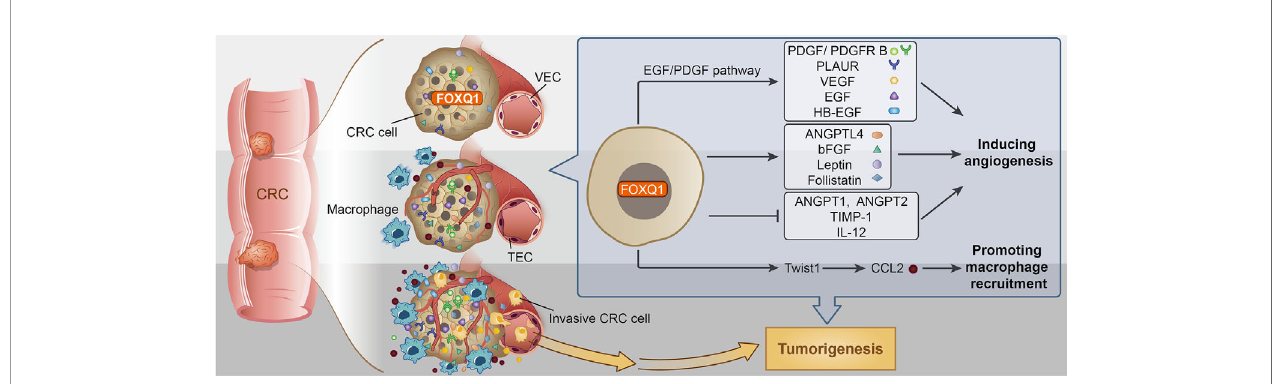
FIGURE 8 | Potential mechanism for Forkhead box Q1 (FOXQ1) induced angiogenesis and macrophage in fi ltration in colorectal cancer (CRC) tumorigenesis. We speculate that FOXQ1 can promote the migration of endothelial cell in tumor microenvironment (TME), improve microvessel morphogenesis, as well as strengthen intercellular interactions between tumor and epithelial cells mainly through activation of EGF/PDGF pathway. We also propose that FOXQ1 can promote macrophage in fi ltration in TME by activating the Twist1/CCL2 axis. Thus, the combined mechanisms of FOXQ1 described in this study support a dual role of FOXQ1 in promoting CRC